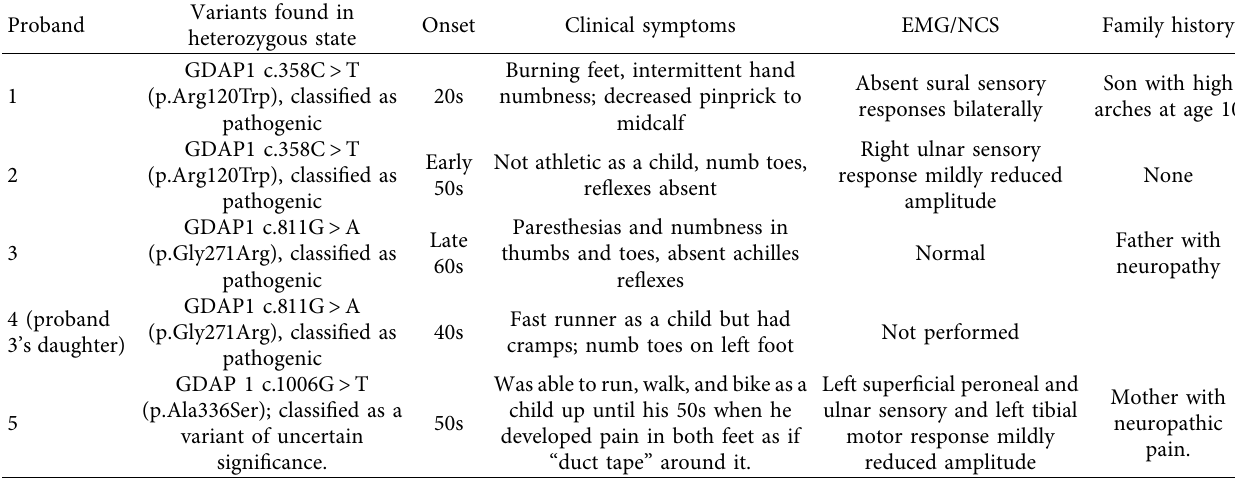
Table 1: Clinical Results of individuals with a heterozygous GDAP1 missense